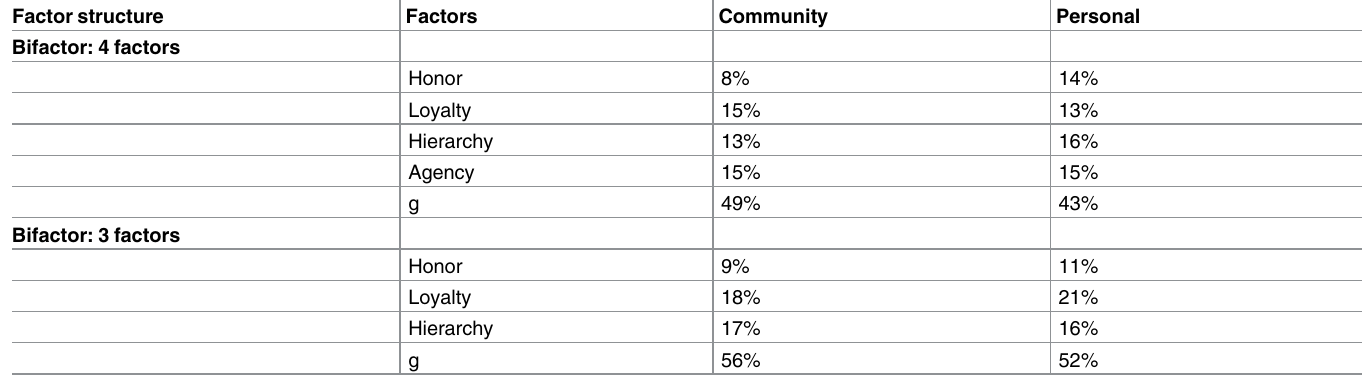
Table 2. Explained variancefor factor structure alternatives.